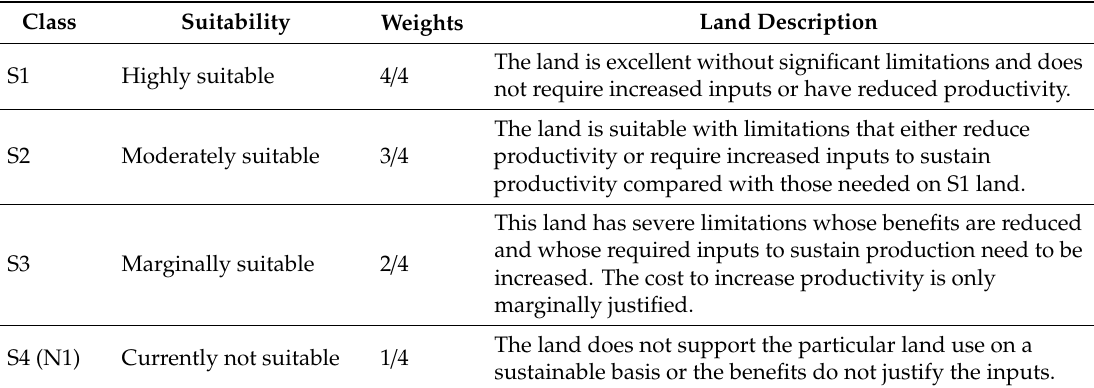
Table 2. Classification of the land suitability framework of FAO.